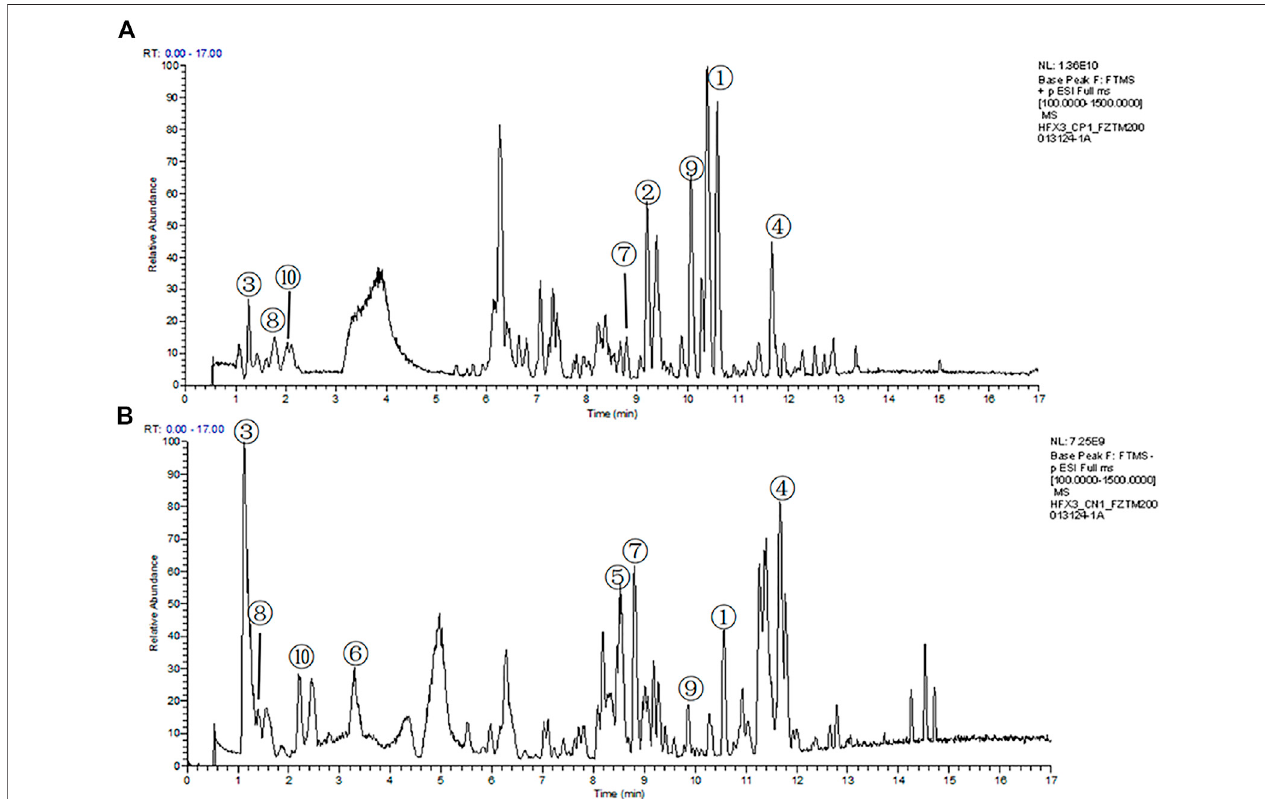
FIGURE 1 | The total ion chromatograms (TIC) of QLZDD that were obtained in (A) the positive (ESI ± ) ionization mode and (B) the negative (ESI − ) ionization mode.